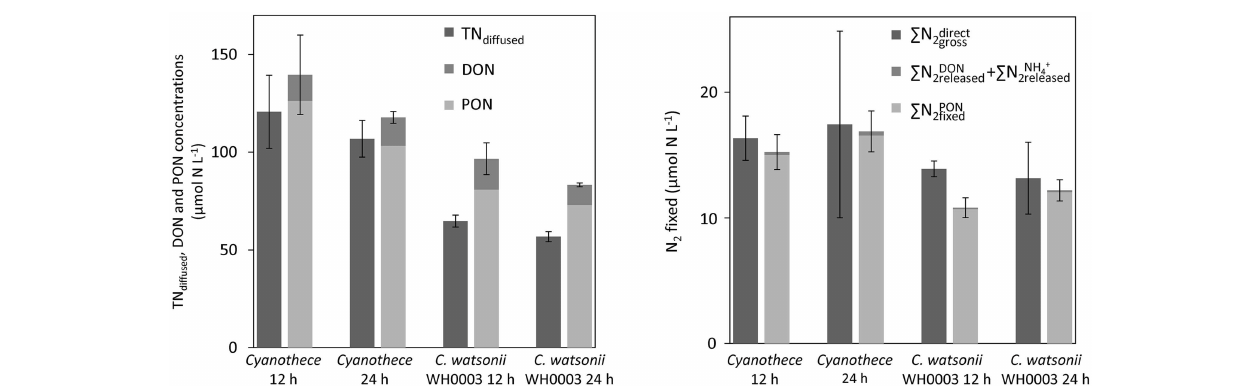
FIGURE 6 | Concentrations of TN recovered using the diffusion method (TN diffused ) and sum of PON and DON concentrations at the 12h and 24h time points in Cyanothece and C. watsonii WH8501 cultures (left). Gross N 2 fixation measured using the 15 N-enrichment recovered from the diffusion of the whole culture medium ( P N 2direct gross ) and as the sum of N 2 incorporated in PON ( P N 2PON fixed ) and released as DON ( P N 2DON released ) and NH + 4 ( P N 2NH4 released ) after 12h and 24h of incubation for Cyanothece and C. watsonii WH8501 (right). Error bars represent the standard deviation of triplicate measurements and the propagated analytical error.